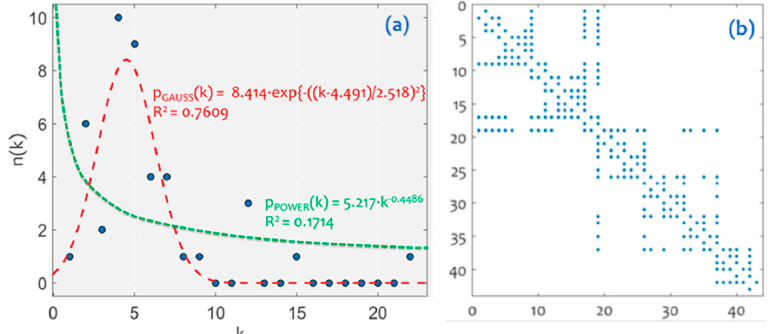
Figure 3. ( a ) The degree distribution p ( k ) of the associated with the Greek COVID-19 infection curve visibility graph G V ( n ( k ) denotes the frequency of degree k ); ( b ) the sparsity (spy) plot of G V .